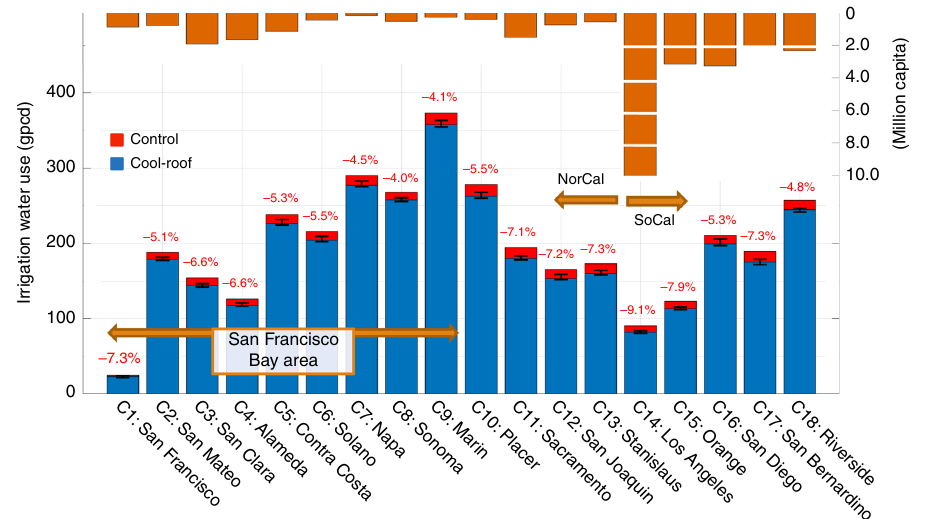
Fig. 2 Simulated irrigation water consumption for control and cool-roof simulations for each county. Values represent averages in gallons per capita per day (gpcd) over urban surfaces for June – October of 2001 – 2015. The error bars illustrate inter-annual fl uctuations of irrigation water consumption reductions induced by cool roofs. County populations are represented in orange bars. Note that daily rates of irrigation water use are calculated by dividing accumulated irrigation water over June – October of each year by 365, assuming irrigation happens only during these warm, dry months of the year